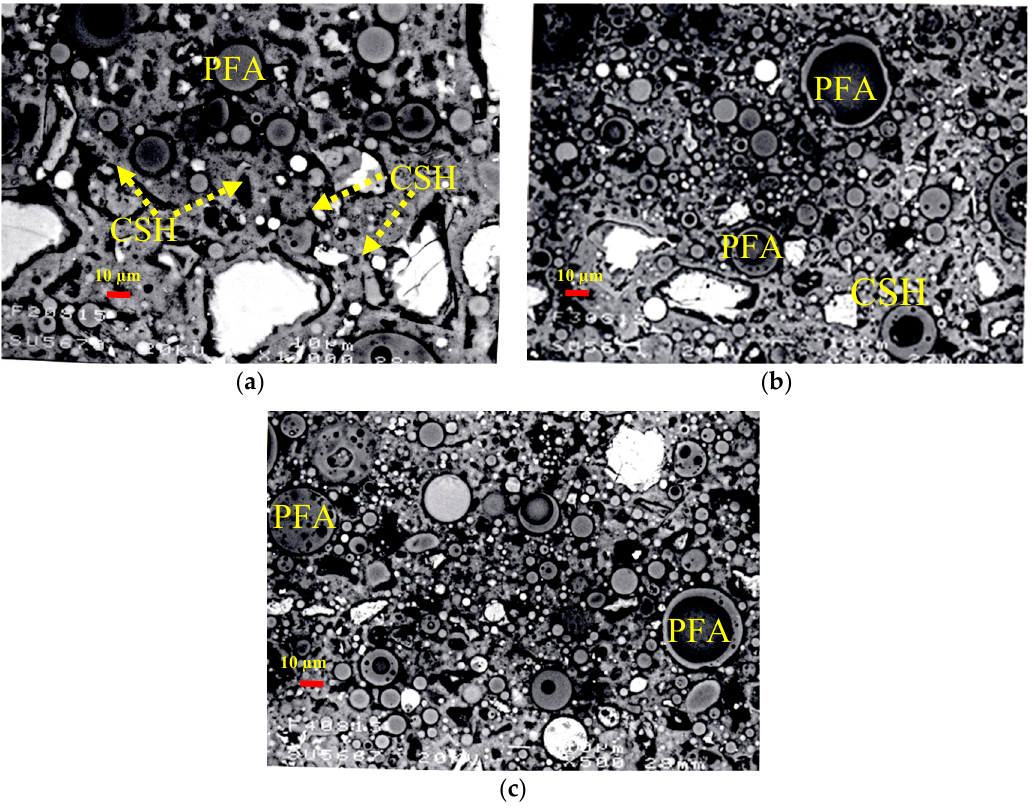
Figure 15. Microstructural analysis of ternary mixtures of PC with PFA and SF; ( a ) 20% PFA + 15% SF, ( b ) 30% PFA + 15% SF, ( c ) 40% PFA + 15% SF.